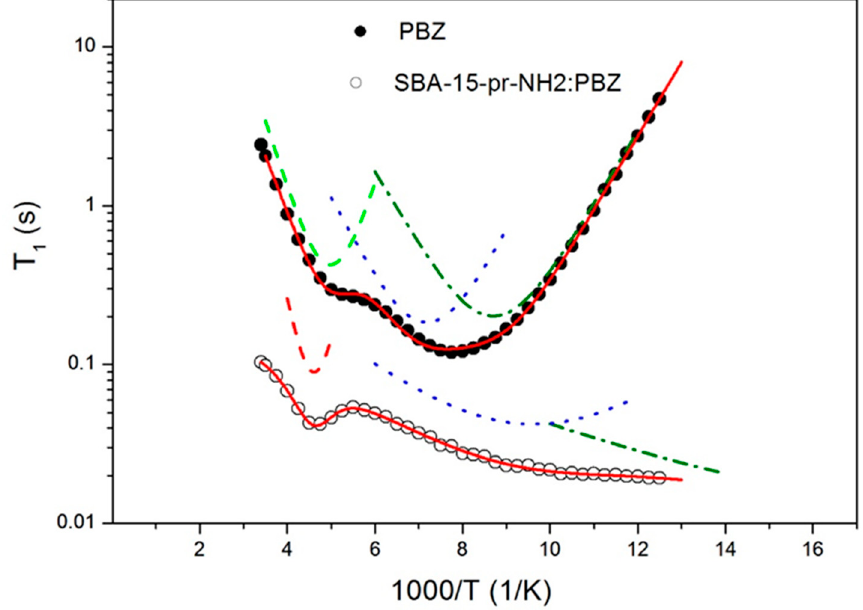
Figure 8. Temperature dependence of the spin-relaxation time T 1 in the laboratory frame for PBZ and SBA-15-pr-NH 2